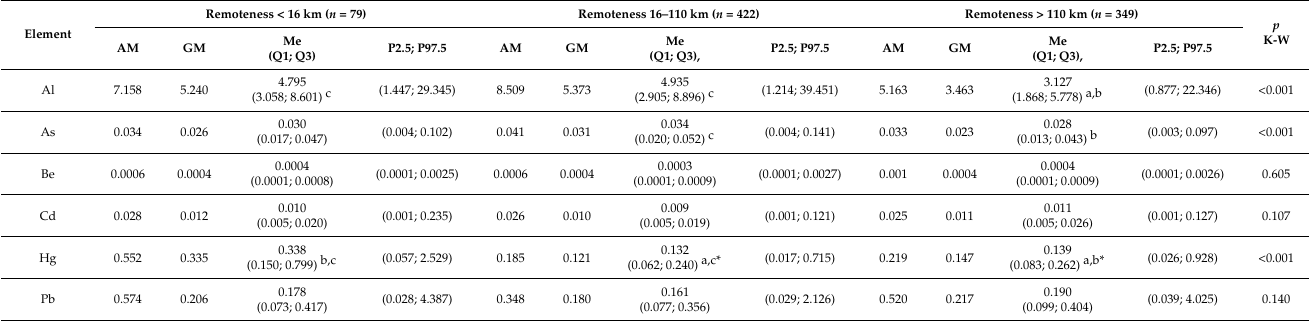
Table 2. Comparative analysis of the concentration of toxic trace elements ( µ g/g) in the hair of residents of western Kazakhstan in 3 groups living at different distances from oil and gas production